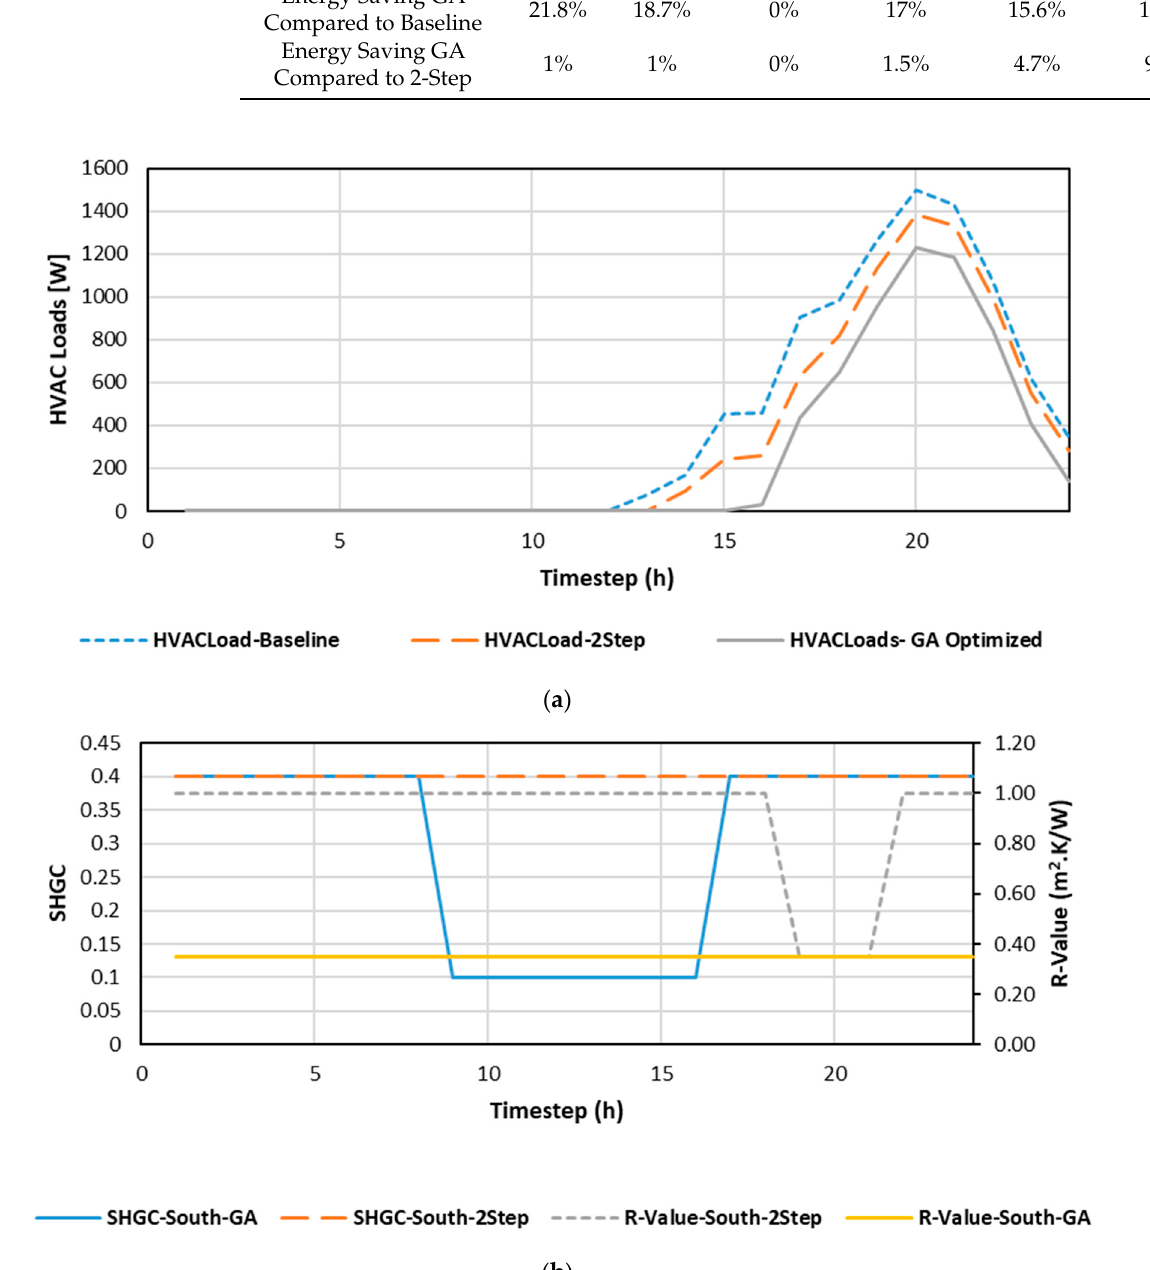
Figure 12. Hourly variations of ( a ) R-values and SHGC settings, and ( b ) thermal loads for an STIS–smart window with southern exposure during a mild day (14 April) for a dwelling located in Chicago, IL, USA.